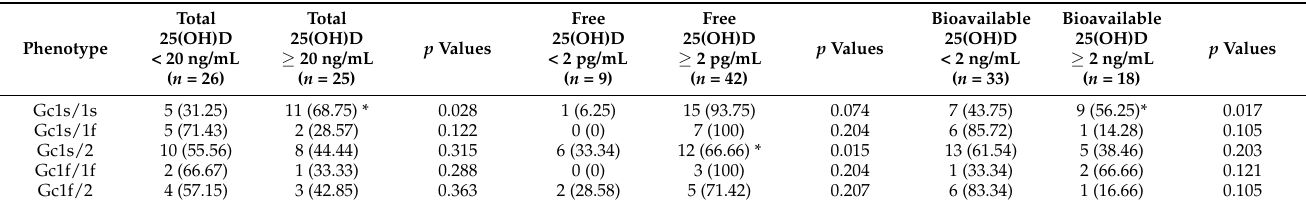
Table 6. Distribution of the phenotypes of GC gene according to the levels of 25(OH)D and free and bioavailable 25(OH)D.